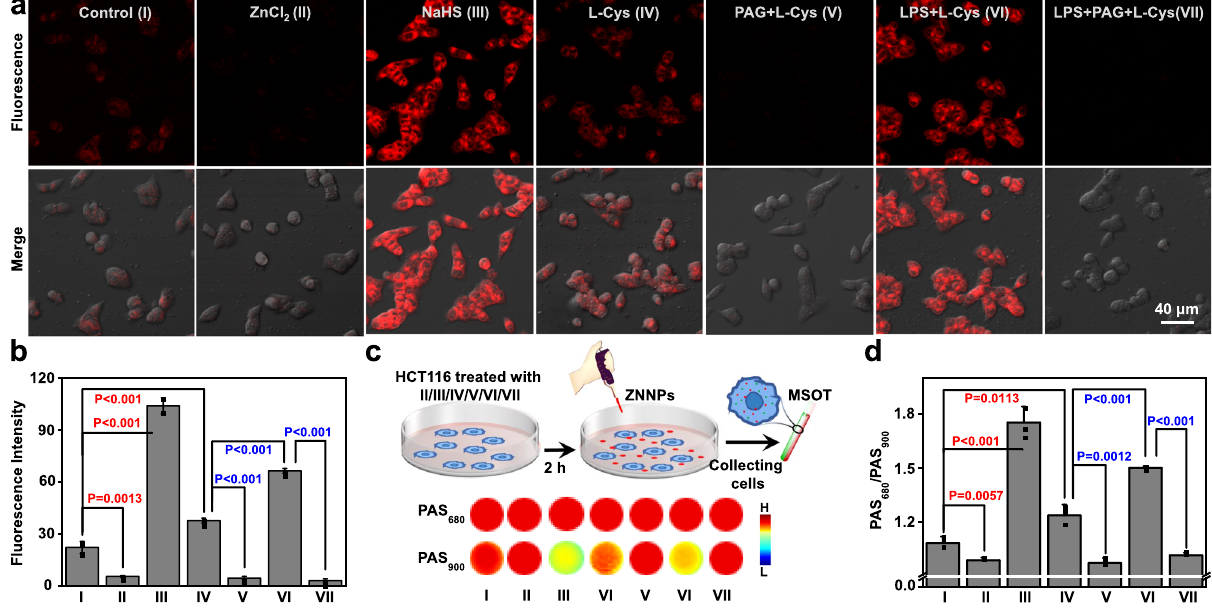
Fig. 3 Visualization of H 2 S in HCT116 cells. a Confocal fl uorescence images and b quantitative fl uorescence intensity of HCT116 cells. c Photoacoustic images and d ratiometric photoacoustic signals (PAS 680 /PAS 900 ) of H 2 S in HCT116 cells. Cells were treated with PBS buffer, ZnCl 2 (40 μ g/mL, 10 min), NaHS (1 mM, 1 h), L-Cys (24 μ g/mL, 1 h), PAG (50 μ g/mL, 0.5 h) + L-Cys (24 μ g/mL, 1 h), LPS (1 μ g/mL, 6 h) + L-Cys (24 μ g/mL, 1 h), or PAG (50 μ g/ mL, 0.5 h) + LPS (1 μ g/mL, 6 h) + L-Cys (24 μ g/mL, 1 h). Data are presented as mean ± s.d. ( n = 3). Statistical differences were analyzed by Student ’ s two-sided t-test. Source data are provided as a Source Data fi